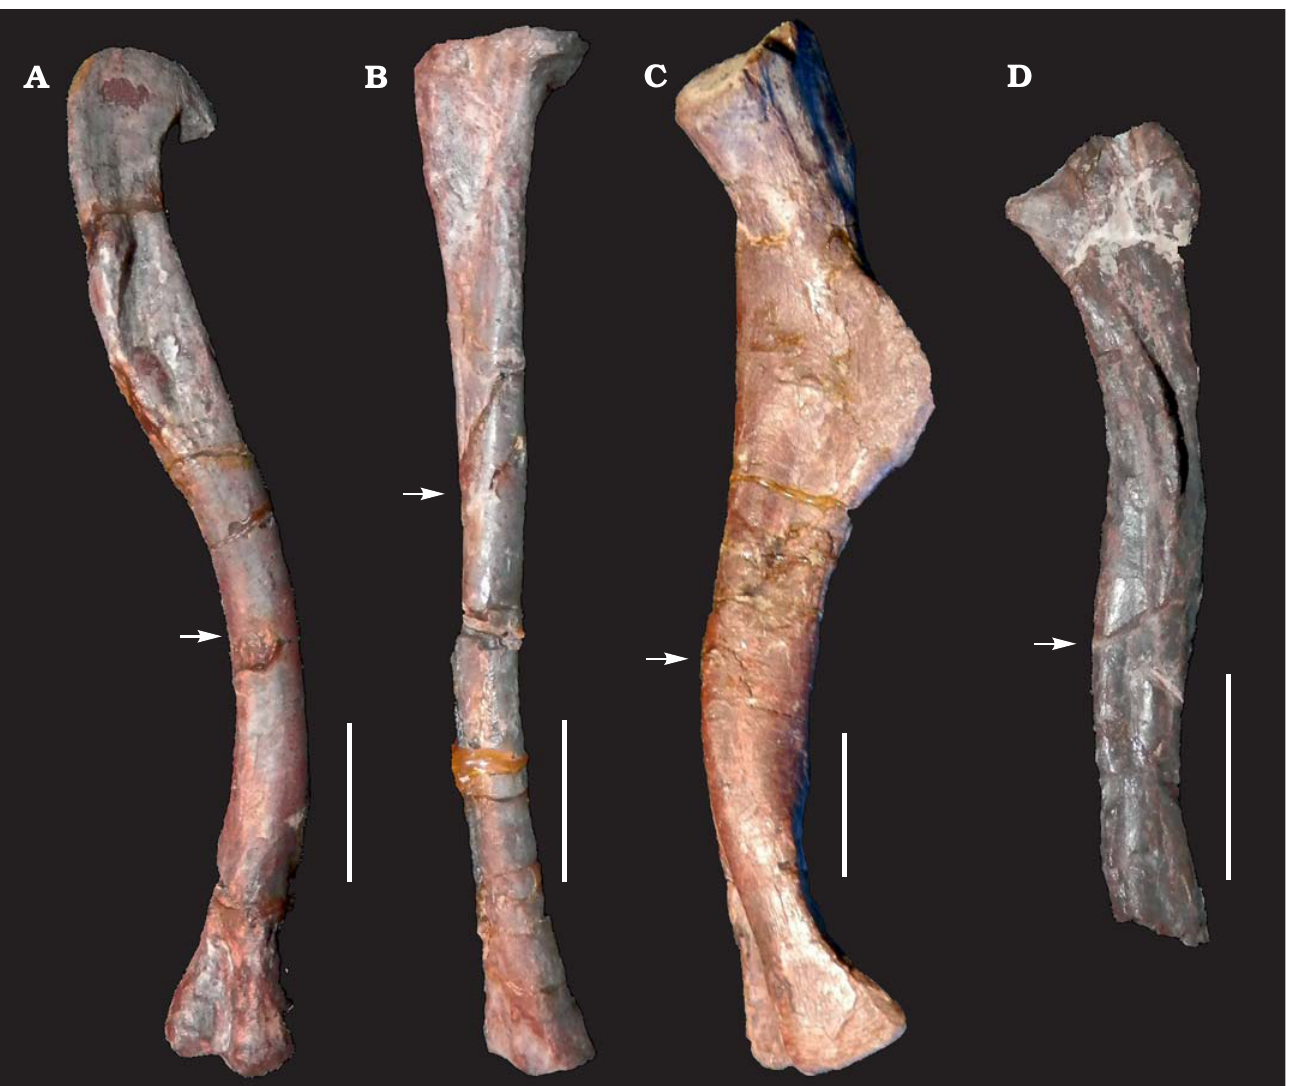
Fig. 1. Long bones of archosauromorphs from La Rioja province, NW Argentina; Chañares Formation, Carnian (Late Triassic). A , B . Lagerpeton chana- rensis Romer, 1971 (PVL-4625) femur in posteromedial view ( A ) and tibia in lateral view ( B ). C . Chana resuchus bonapartei Romer, 1971 (PULR-V 125), femur in posteromedial view. D . Tropidosuchus romeri Arcucci, 1990 (PVL-4604), femur in posteromedial view. Arrows indicate place of the mid- shaft extraction of bone tissue samples. Scale bars 10